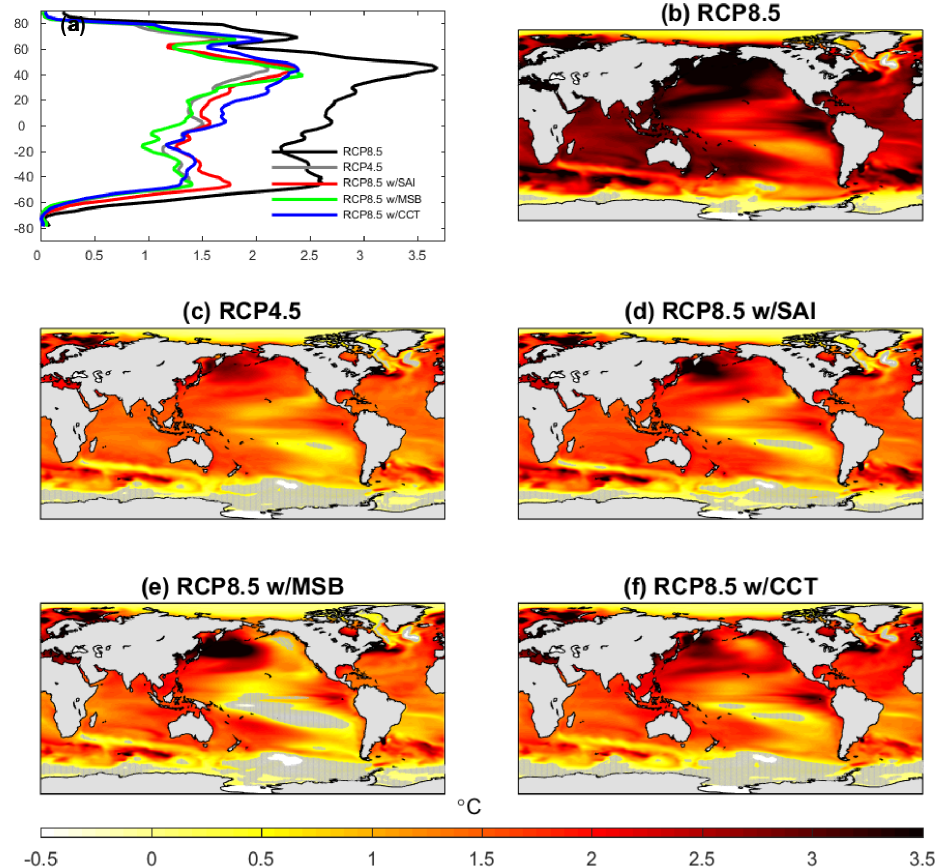
Figure 3. The absolute change in sea surface temperature (SST) in 2071–2100 relative to 1971–2000 (in ◦ C). Panel (a) shows zonally averaged (in 2 ◦ latitude bands) change for all simulations. Global maps of (b) RCP8.5, (c) RCP4.5, (d) RCP8.5 with SAI, (e) RCP8.5 with MSB, and (f) RCP8.5 with CCT. Gray shading in panels (b–f) indicates areas where the change is not significantly different from